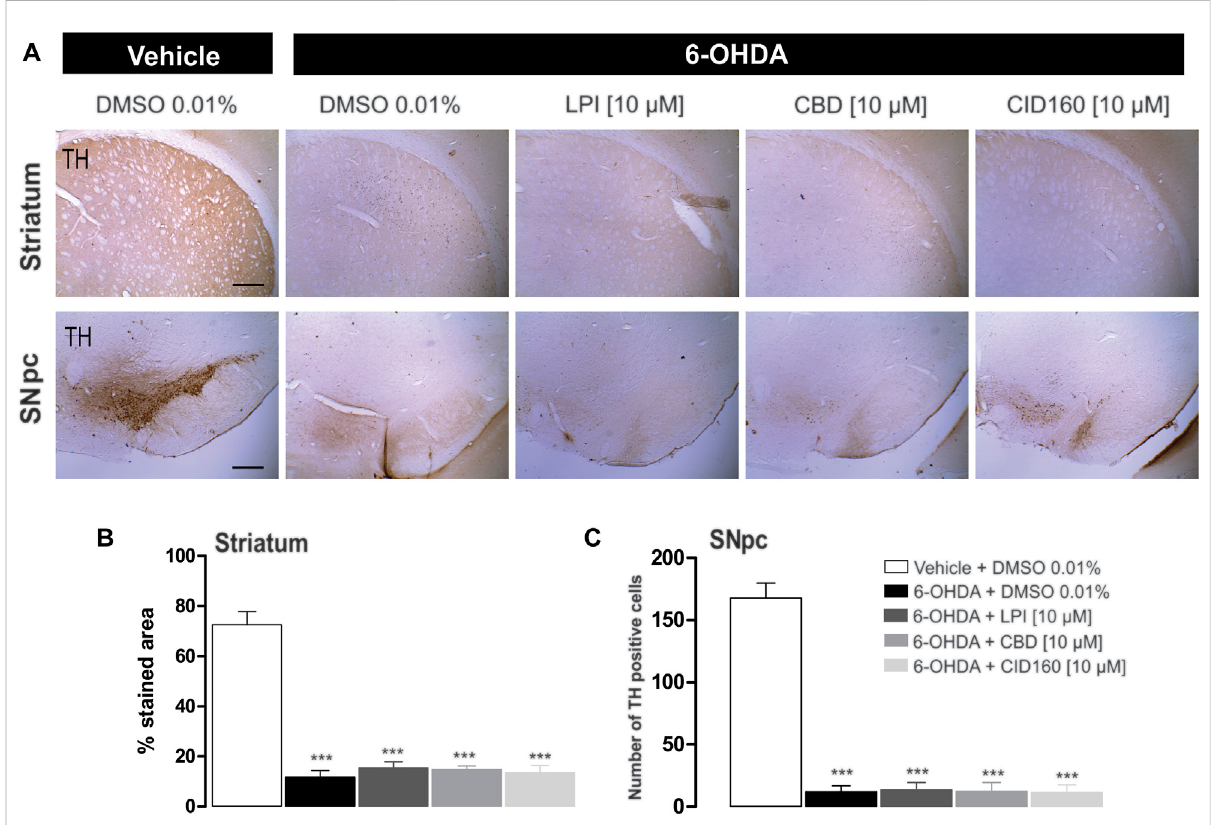
FIGURE 7 TheadministrationofLPI,CBD,andCID16020046doesnotmodifytheexpressionofTHinthestriatumandSNpc.Thephotomicrographyin (A) shows the representative images for TH expression in the striatum ipsilateral to the 6-OHDA lesion induced in the MFB. Photomicrographs were taken at 40x, while the scale bar represents 500 µm. Graph (B) shows the proportion of the area stained for TH in the striatum and Graph (C) shows thenumberofTH-positivecellsintheSNpc.AllgroupsshowdecreasedimmunoreactivitytotheTHenzyme.Thevaluesshowmean±SEM( n = 4 per group). The statistics were determined via a one-way ANOVA and a Tukey post-hoc test. *** p < 0.001 vs . vehicle